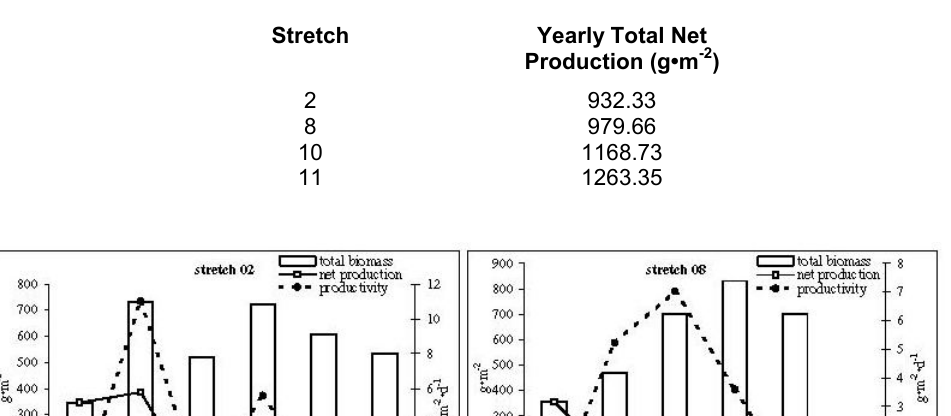
Net Production of Herbaceous Vegetation